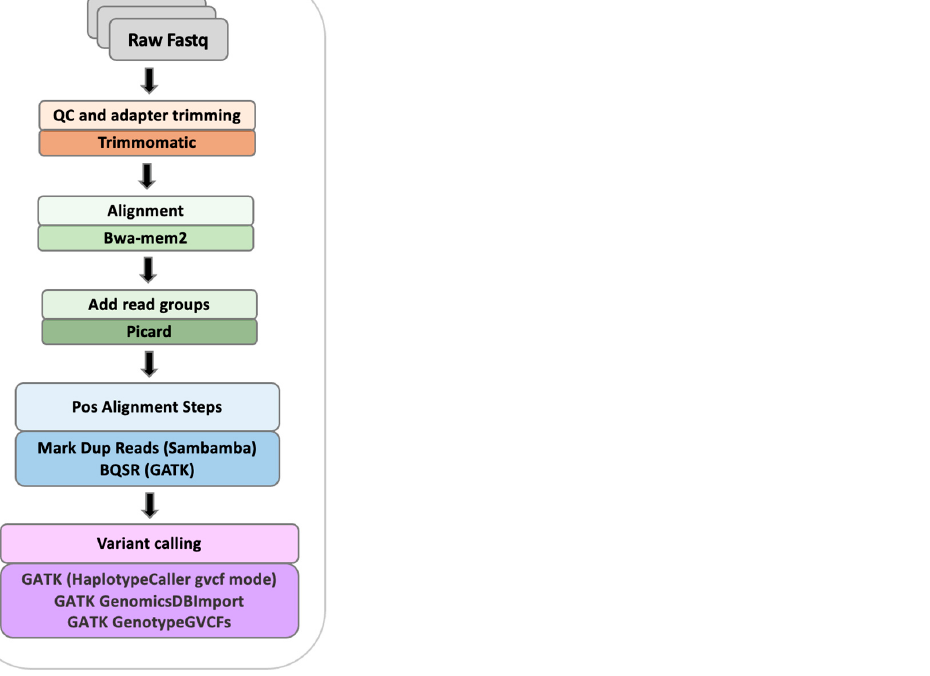
Figure 2. Plot of first two principal components of the large multi-breed reference including Hanwoo animals. 2.2. Target Genotype Data After sample quality control (samples with more than 10% of genotypes missing were excluded), a total of 9732 animals genotyped with the Illumina BovineSNP50 v2 (50K) and 991 animals genotyped with Illumina BovineHD chip (HD, 770K) were used as the target −0.01